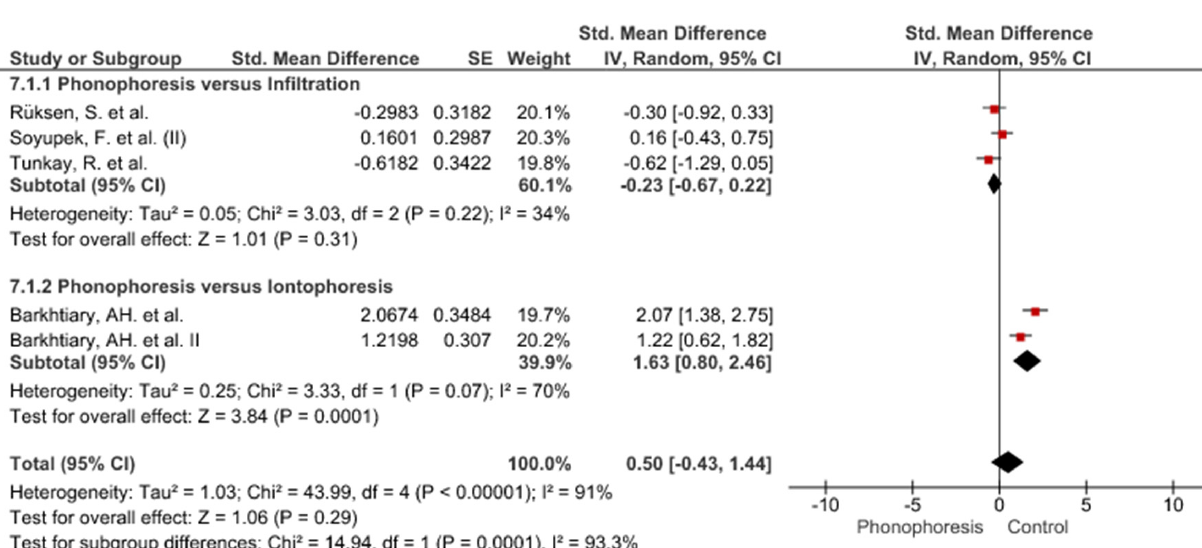
Figure 7. Phonophoresis for LMSensor.